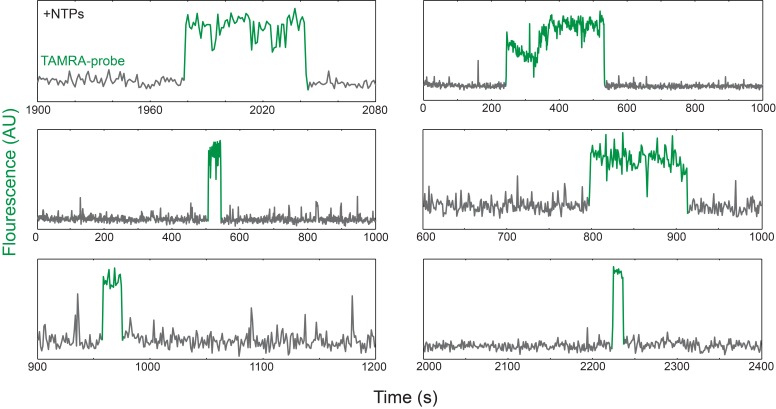
Additional examples of time records of transcript probe (green-excited) fluorescence co-localized at single rrnB P1 DNA locations.Data are plotted as in Figure 2B.